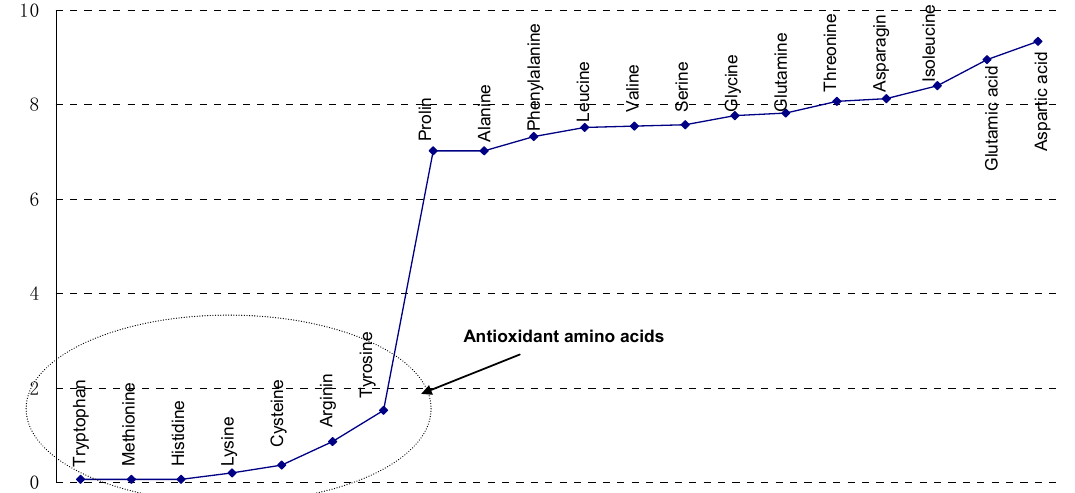
Figure 2. Categorization of twenty amino acids based on experimental evaluation. The value of quantitative index is inversely proportional to antioxidant activity.